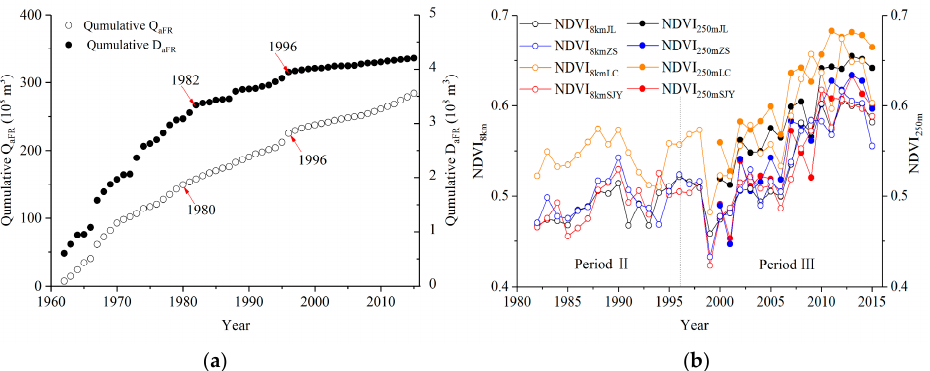
Figure 7. Temporal variation in ( a ) cumulative Q aFR from 1962 to 2015 and D aFR from 1960 to 2015; ( b ) NDVI 8km from 1982 to 2015 and NDVI 250m from 2000 to 2015.